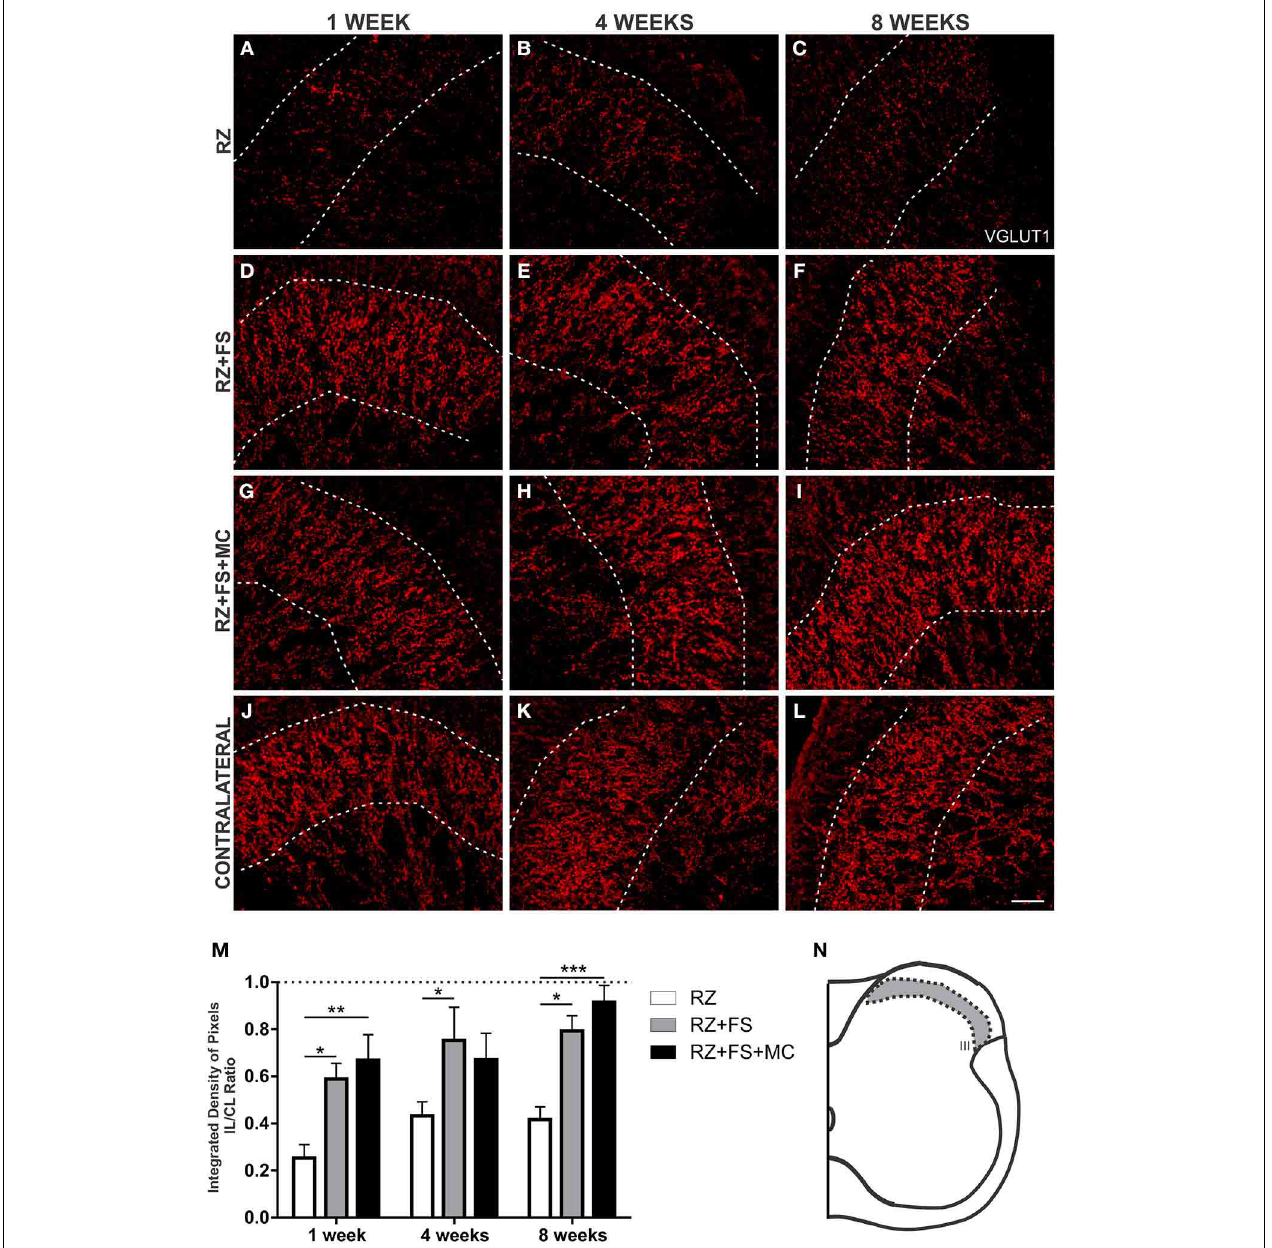
FIGURE 8 | Immunohistochemistry for vesicular glutamate transporter 1 (VGLUT1). (A–L) Representative images of RZ, RZ + FS and RZ + FS + MC, 1, 4, and 8 weeks post lesion. (M) Quantification (ratio IL/CL) of the integrated density of pixels, obtained in the